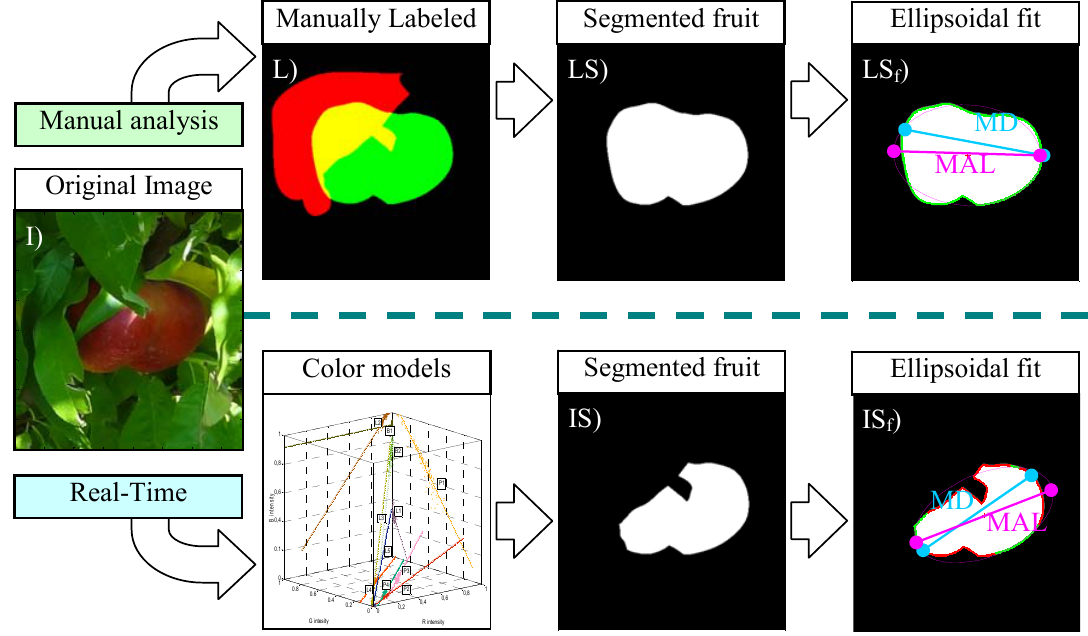
Figure 7. Peach size estimate analysis: ( I ) original sample image, ( L ) manually labeled image, ( LS ) complete fruit segmentation, ( IS ) automatic fruit segmentation (with ) and ( IS ) results of the diameter occlusion), and ( LS f f